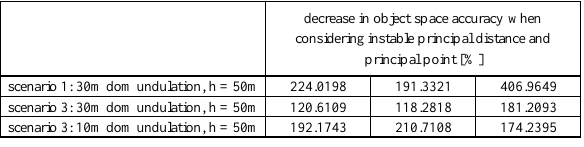
Table 7. Percentage decrease in object space accuracy considering instable interior